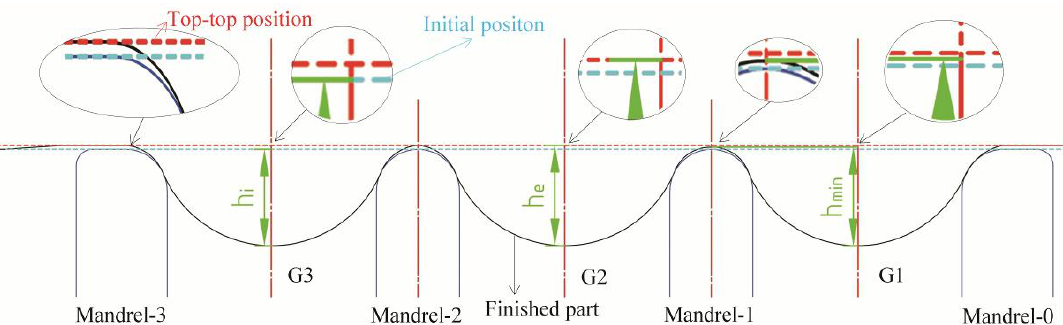
Figure 6. Groove depth measurement methods.